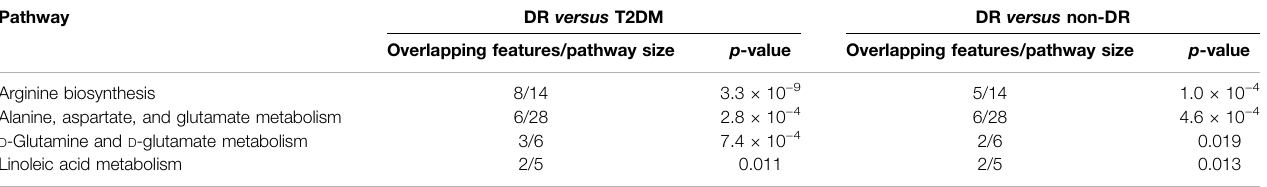
TABLE 5 | KEGG enrichment pathways altered in both DR versus T2DM and DR versus non-DR.